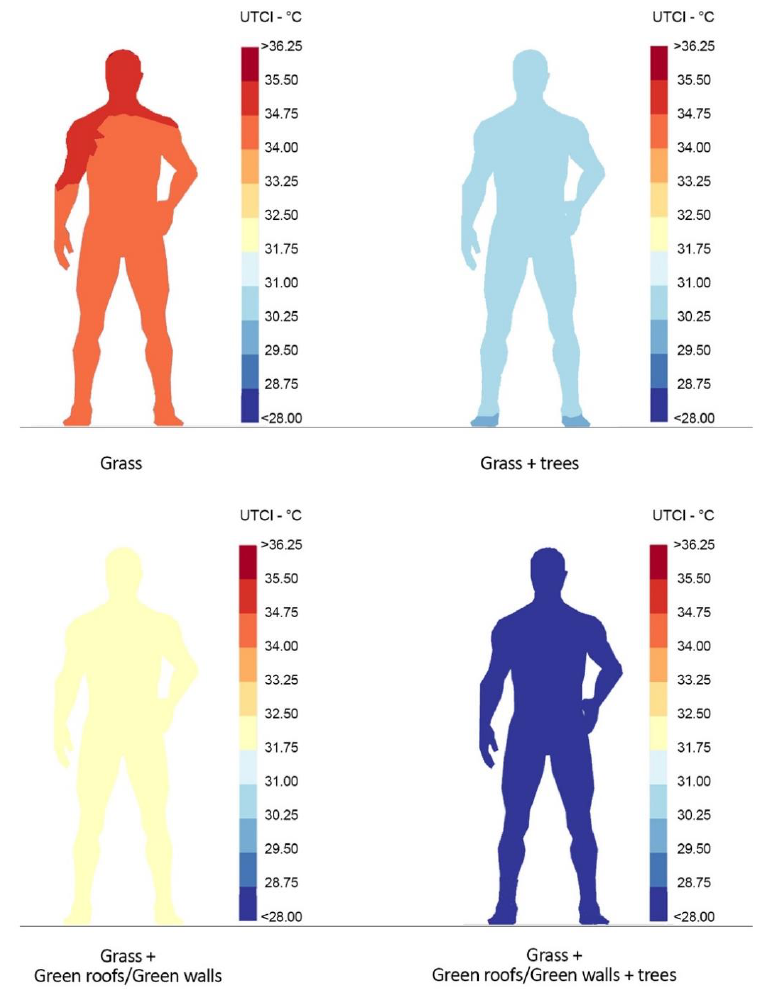
Figure 7. Scenario 3: grass.